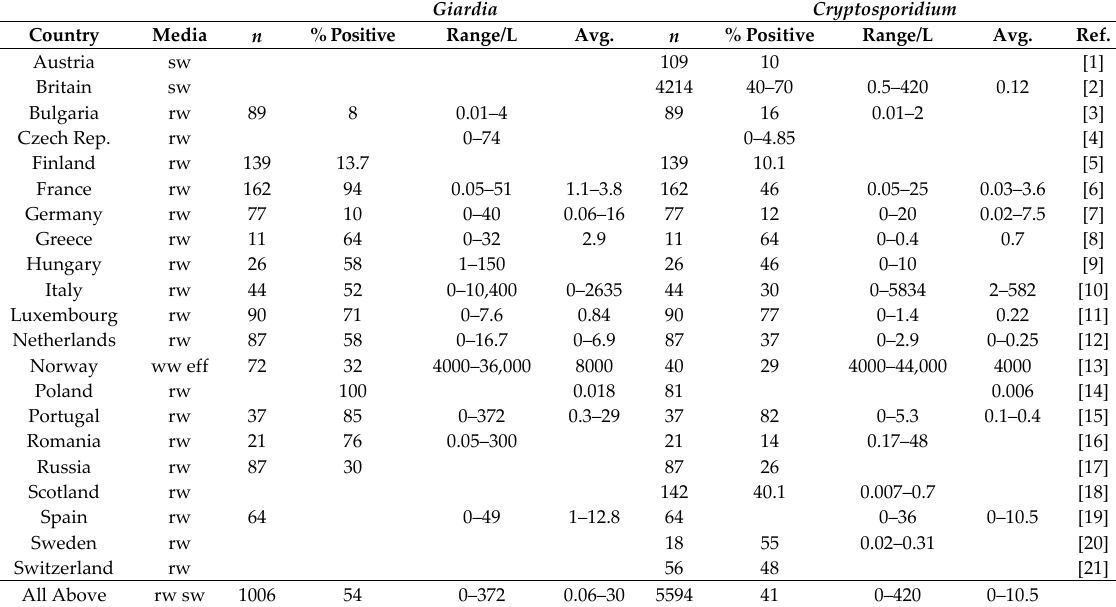
Table 1. Reported Giardia and Cryptosporidium occurrence levels (cysts/L, oocysts/L) including sample origin, number of samples, percent positive reported range and averages, by